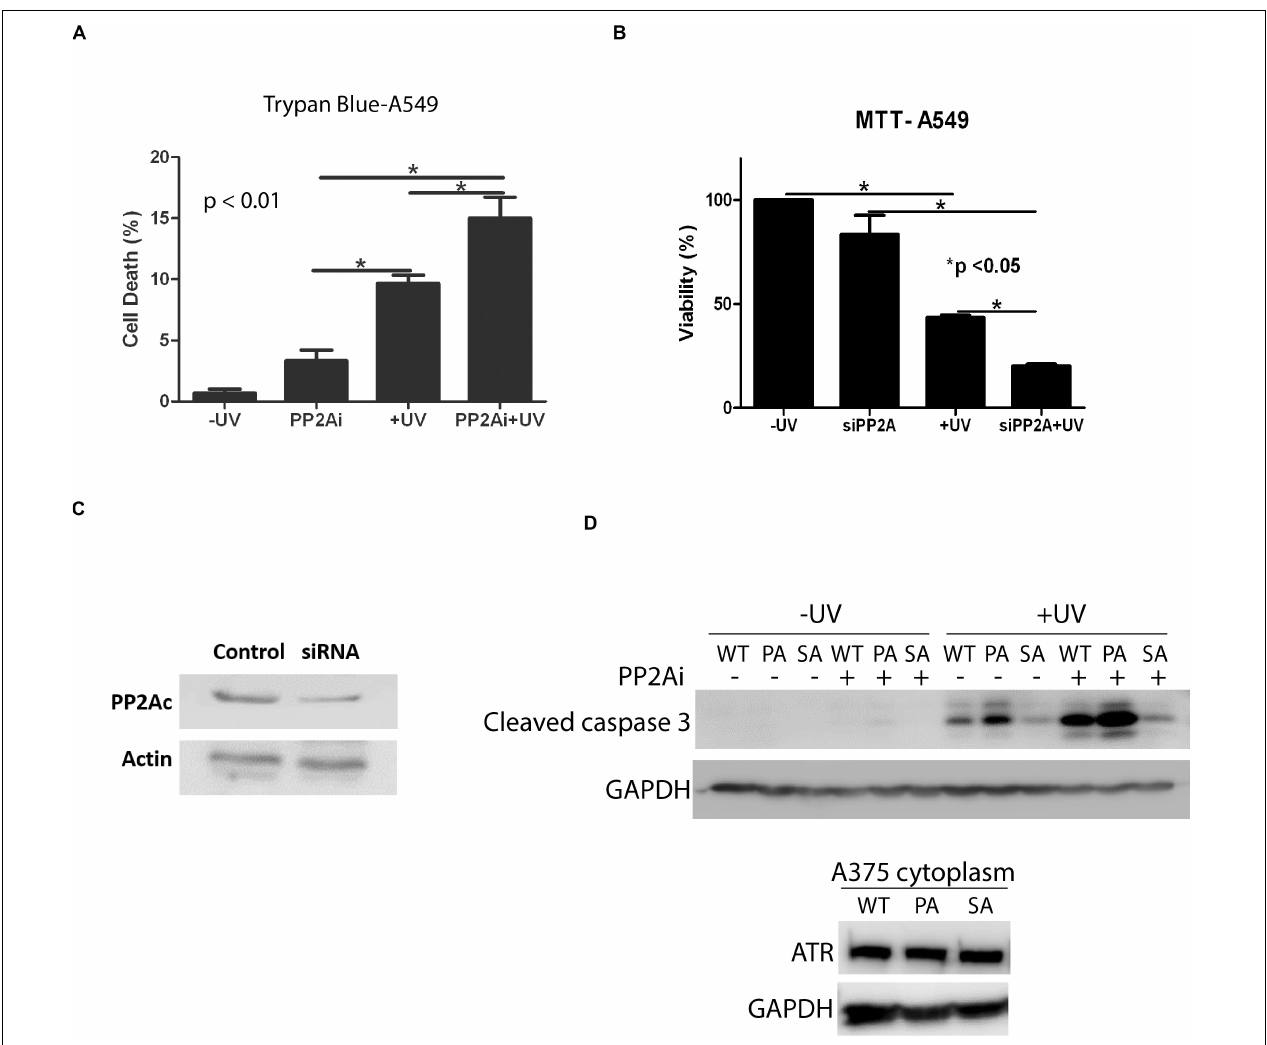
FIGURE 5 | Inhibition of PP2A decreases cellular viability which is enhanced UV-induced DNA Damage. (A) A trypan blue exclusion assay shows that PP2A depletion with siRNA knockdown increases apoptosis in A549 cells and that the level of apoptosis is increased further by UV irradiation at 40 J/m 2 with a 24 h recovery time. (B) MTT assay showing increased levels of apoptosis in A549 cells depleted of PP2A by siRNA knockdown which is enhanced by UV irradiation at 40 J/m 2 and a 24 h recovery time. (C) WB showing PP2A siRNA knockdown efficiency in A549 cells. (D) WB shows the caspase 3 cleavage assay which